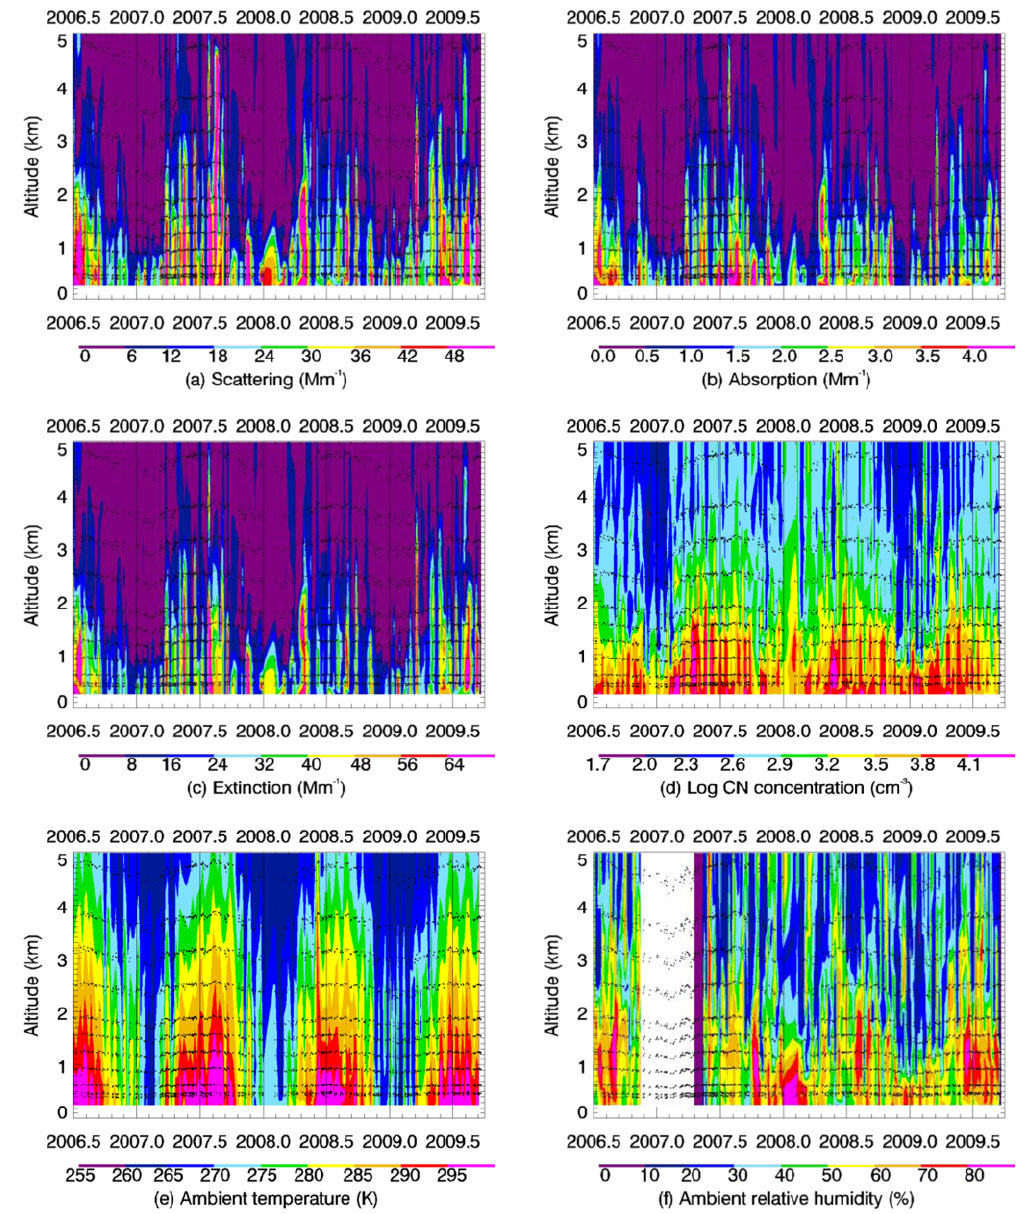
Fig. 9. Time series contour plots of AAO measurements. Black dots represent individual flight